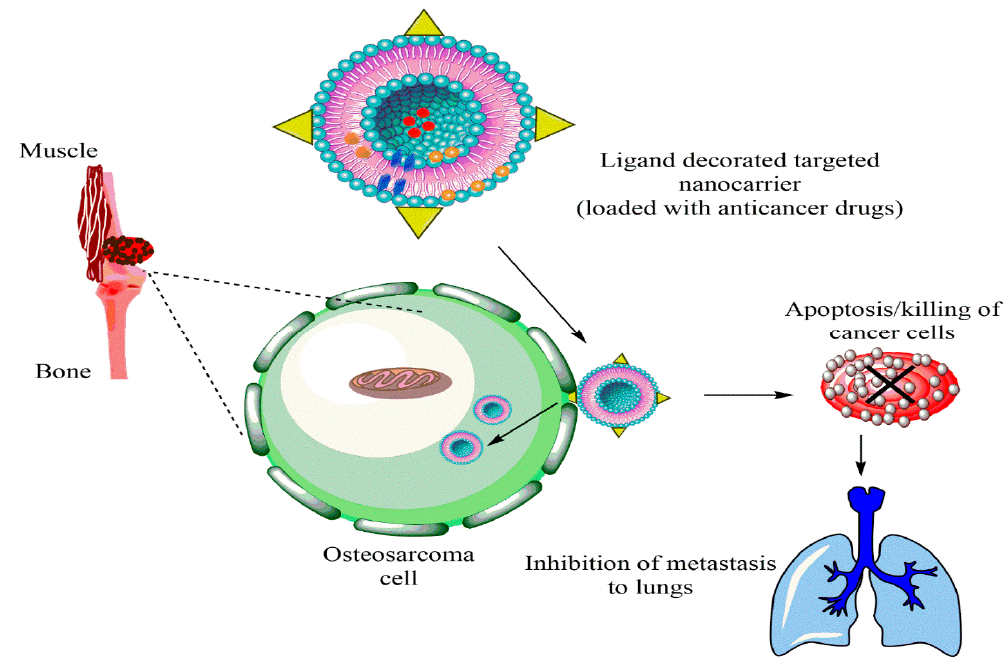
Figure 3. Hypothetical representation of liposome used for multiple targeting strategies in cancer.